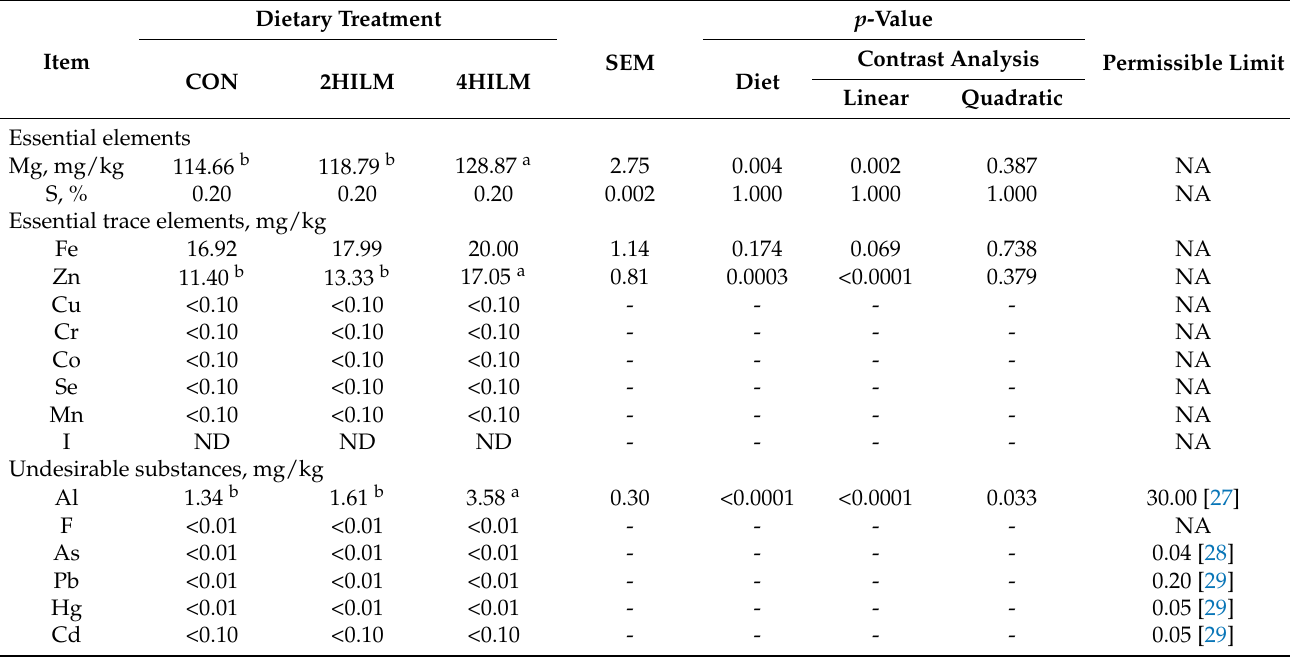
Table 9. Heavy metal concentration in the eggs of laying hens that fed on Hermetia illucens larvae meal